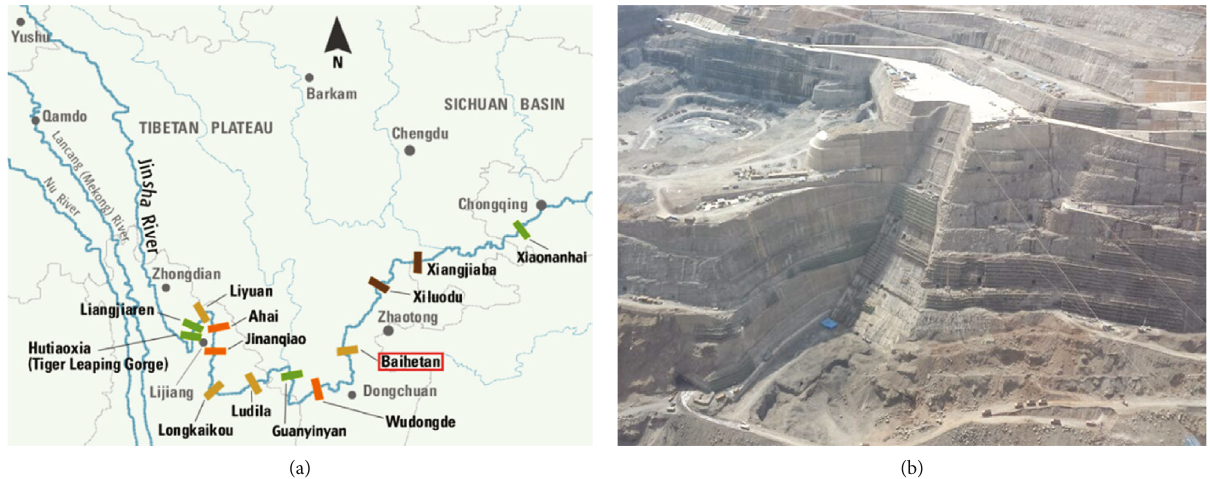
Figure 2: Baihetan Hydropower Station: (a) location of the hydropower station and (b) construction site.